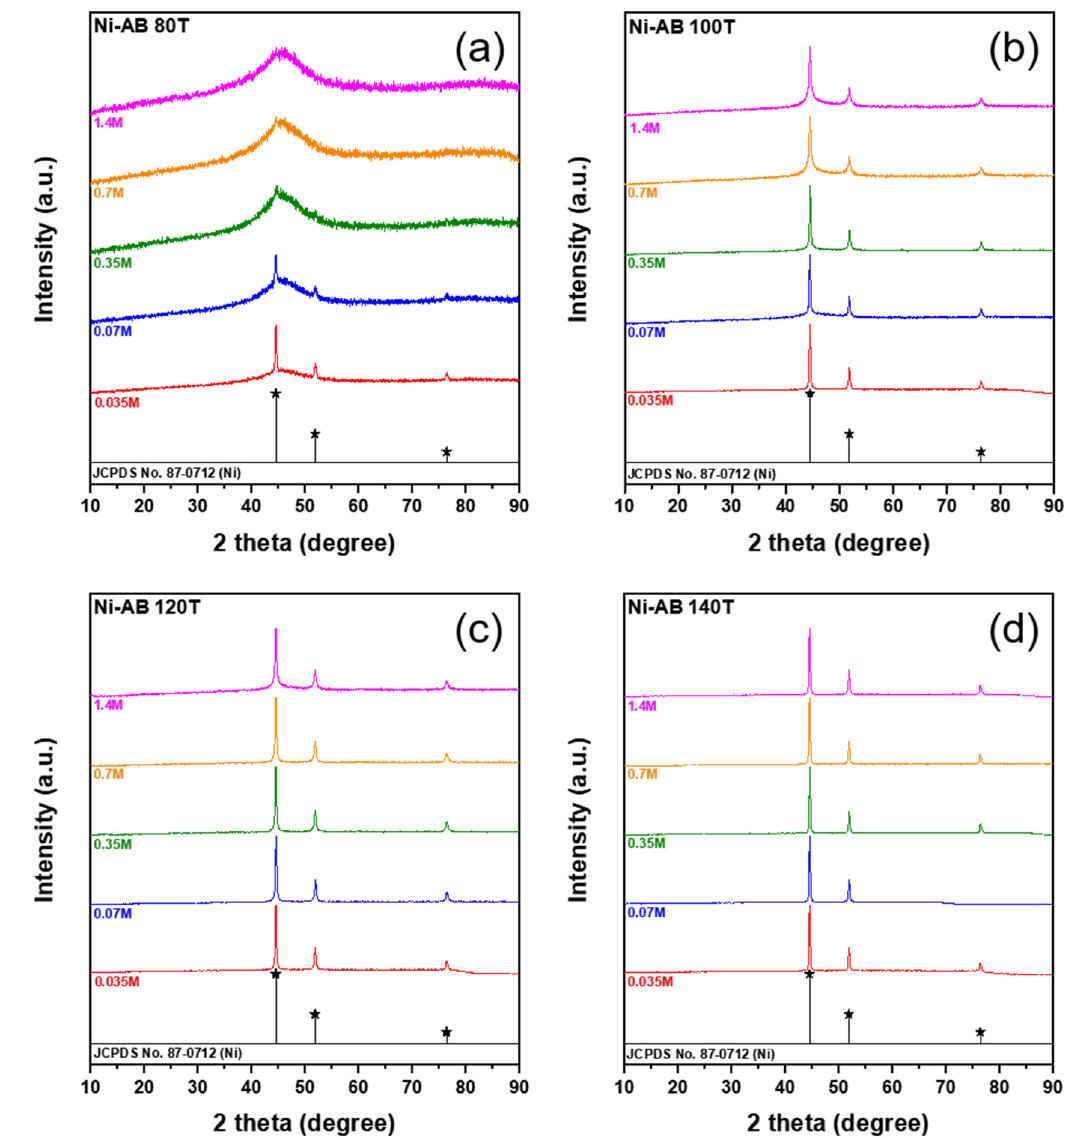
Figure 5. XRD patterns of Ni nanoparticles synthesized at 0.035 M, 0.07 M, 0.35 M, 0.7M, 1.4M of borane-ammonia complex concentration under ( a ) 80 °C, ( b ) 100 °C, ( c ) 120 °C, and ( d ) 140 °C. ( ★ = (111), (200), and (220) plane of face centered cubic Ni phase, respectively)